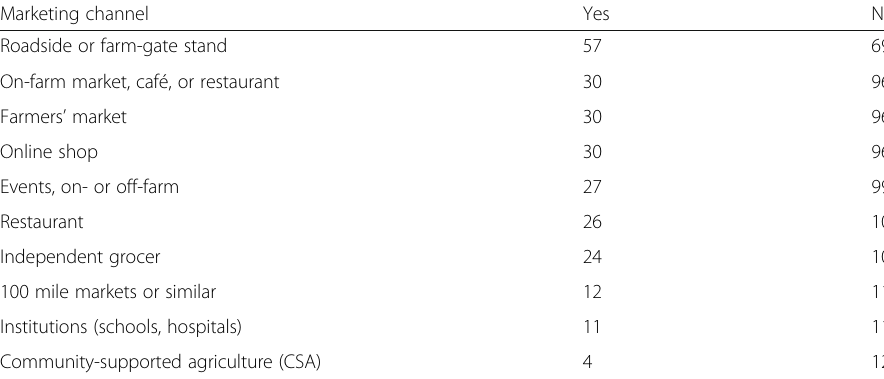
Table 4 Marketing channels used in 2012 Marketing channel